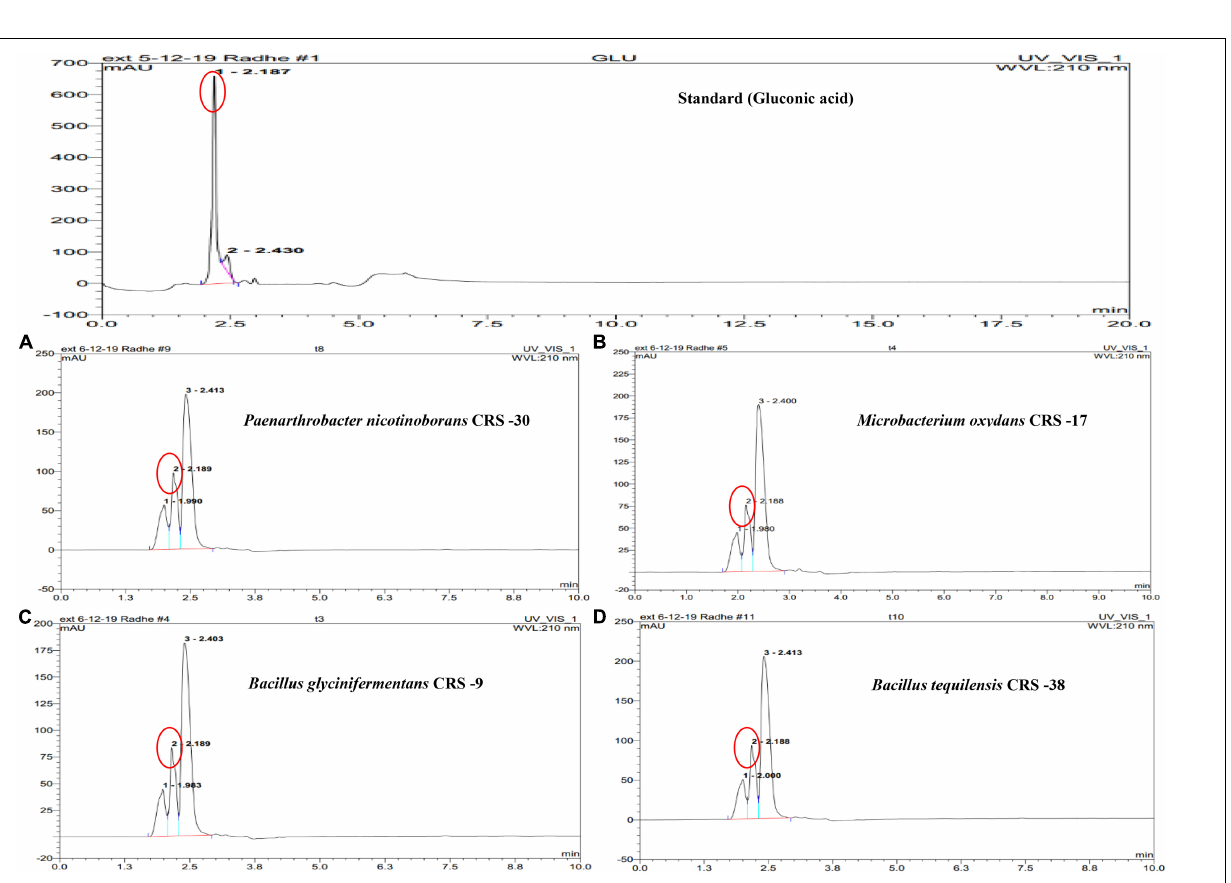
Frontiers in Plant Science |